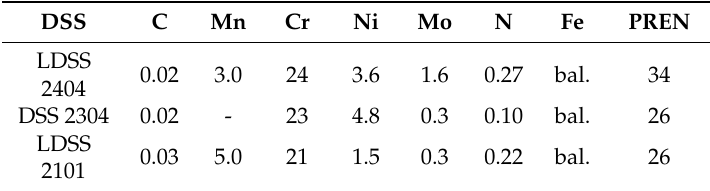
Table 1. Nominal chemical composition (mass %) and PREN values (PREN = %Cr + 3.3 × %Mo + 16 × %N [32]) of the studied duplex stainless steels (DSS) and the reference lean-duplex stainless steel (LDSS) 2101. DSS